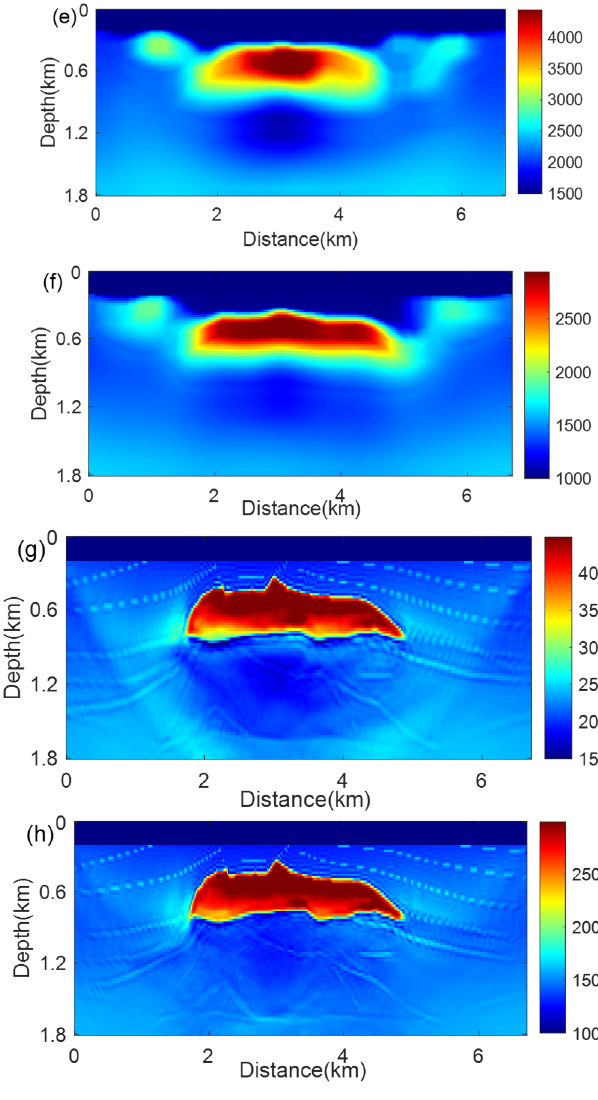
Figure 6. Inversion results with and without ATV constraint. ( a ) Inverted Vp by EDEI; ( b ) Inverted Vs by EDEI; ( c ) Inverted Vp by EDEI + EFWI; ( d ) Inverted Vs by EDEI + EFWI; ( e ) Inverted Vp by EDEI-ATV; ( f ) Inverted Vs by EDEI-ATV; ( g ) Inverted Vp by EDEI-ATV + EFWI-ATV; ( h ) Inverted Vs by EDEI-ATV +EFWI-ATV.